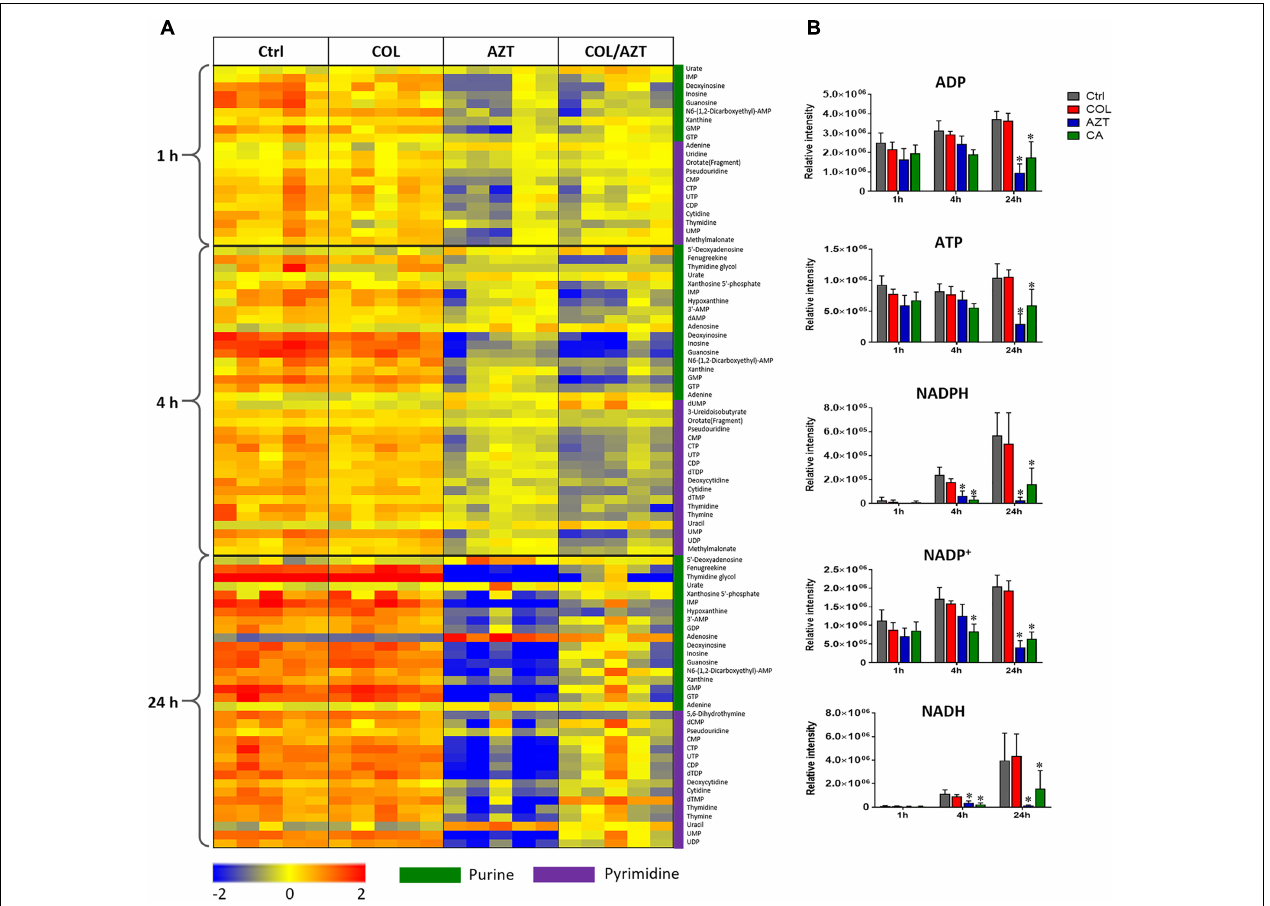
FIGURE 7 | Perturbations of nucleotide metabolism. (A) Heatmap profiles of the relative abundance of nucleotide metabolites after treated with colistin (COL), aztreonam (AZT) and the combination (COL/AZT) at 1, 4, and 24 h. (B) Significantly altered metabolites associated with nucleotide metabolism due to aztreonam alone and the combination of colistin and aztreonam at 1, 4, and 24 h in A. baumannii AB090342. ∗ log 2 FC ≥ 1 or ≤ –1, p < 0.05, FDR < 0.05 (one-way ANOVA). Metabolomics data were collected from five biological replicates per